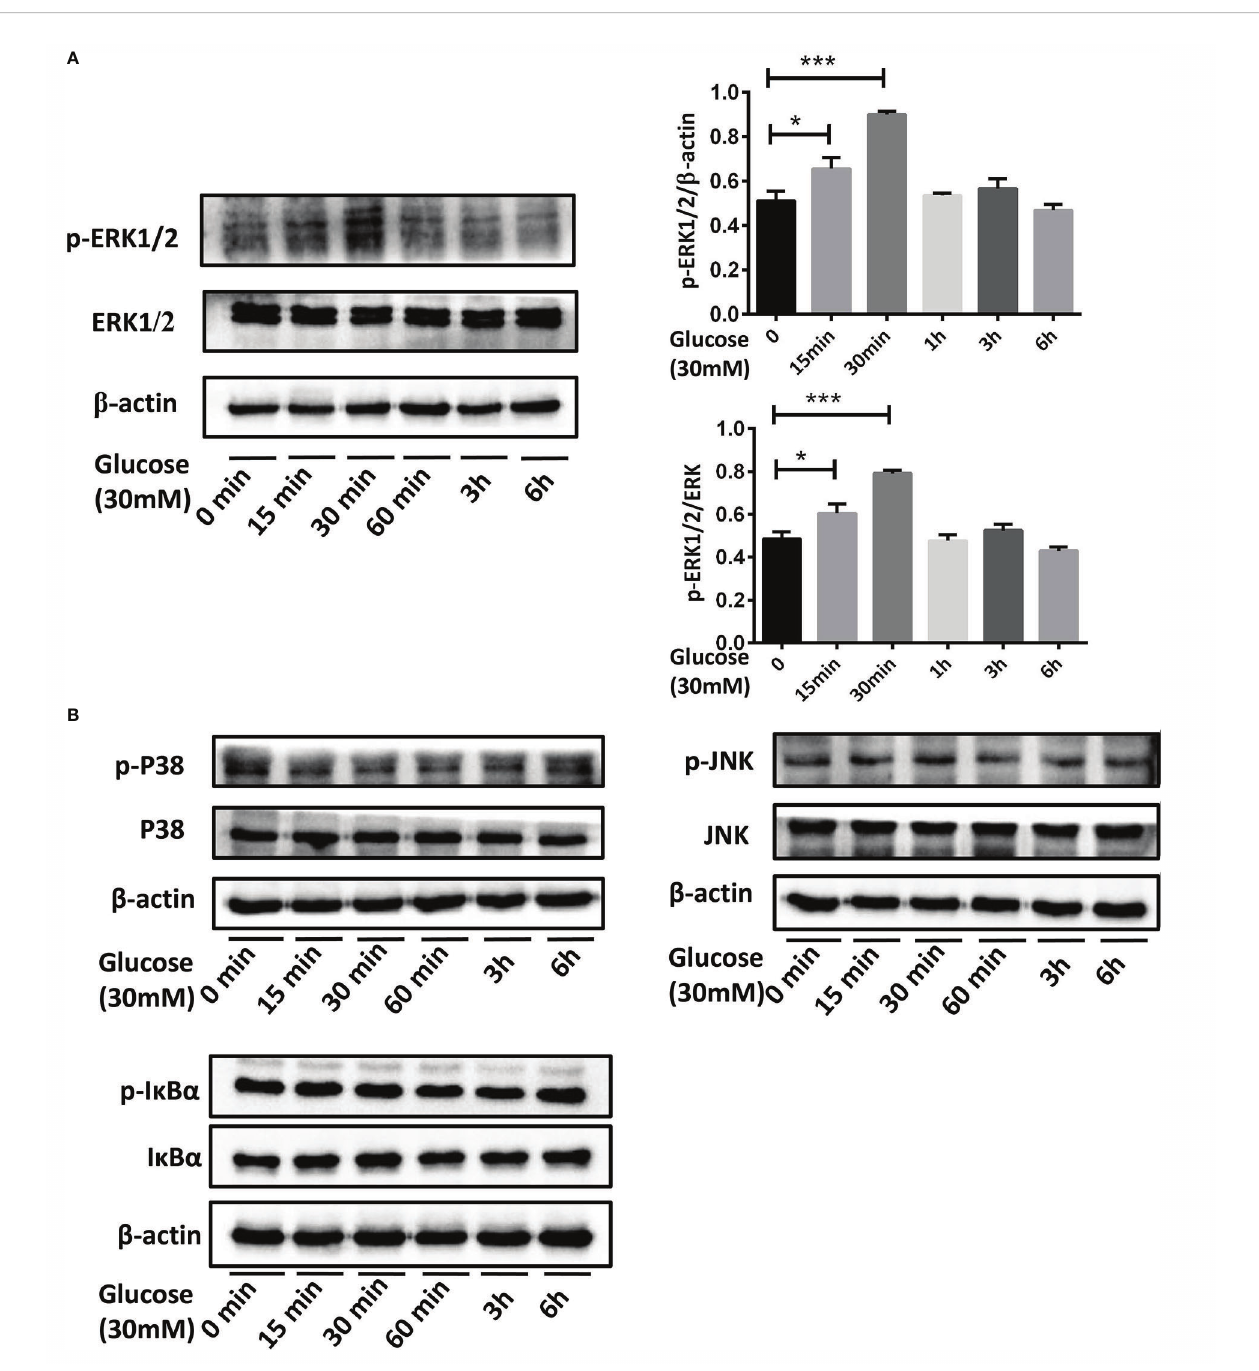
FIGURE 7 The activation of MAPK and NF- k B pathways in BEAS-2B cells stimulated by high glucose. (A) Compared with the control group, p-ERK1/2 in BEAS-2B cells was up-regulated when stimulated by 30mM glucose for 15 minutes and 30 minutes. (B) P38, JNK or I k B didn ’ t activate at each point from 15 minutes to 6 hours when stimulated by 30mM glucose. The blots and densitometry analysis data are representative of three independent experiments. * P < 0.05, and *** P <